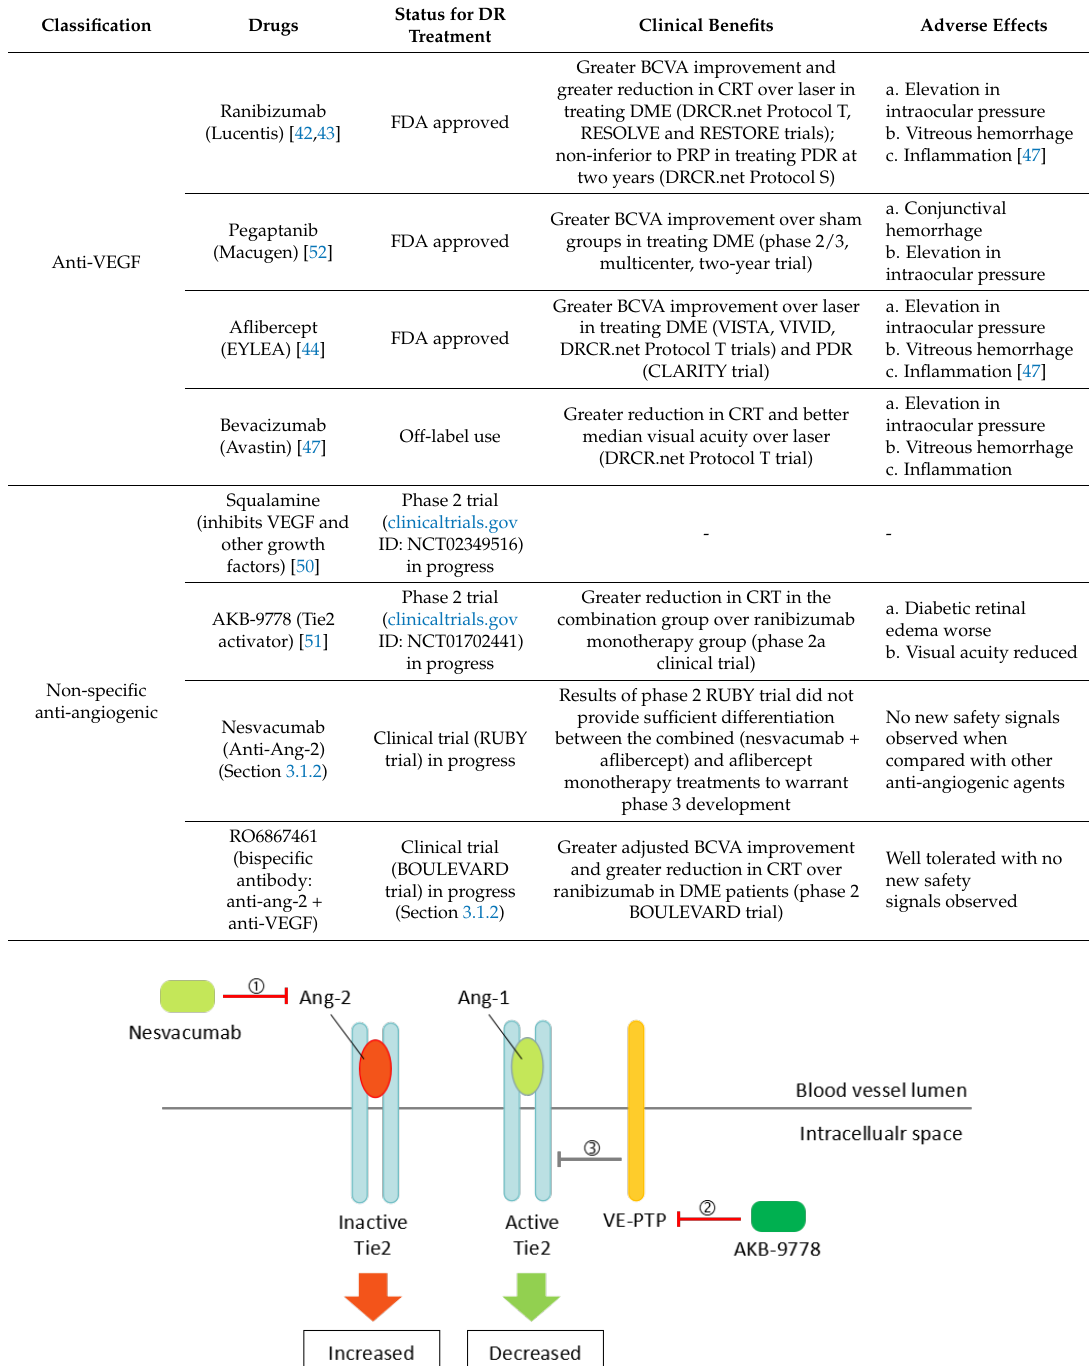
Table 1. Anti-angiogenic agents for the treatment of DR.